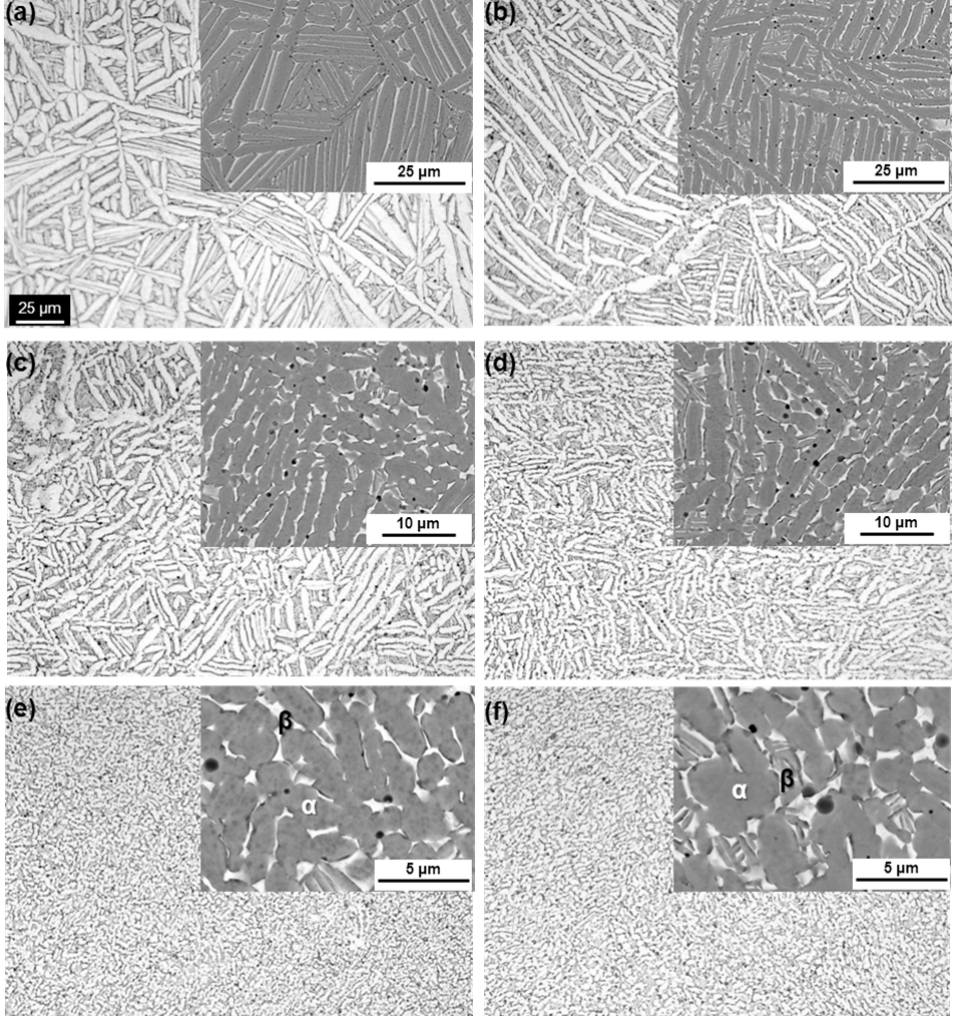
Figure 7. Comparison of optical microscopy and SEM images of Ti-15Zr-4Nb-4Ta alloy A forged at 760 °C. ( a ) β -Annealed; ( b ) forging ratio of 2; ( c ) forging ratio of 3; ( d ) forging ratio of 5; ( e ) forging ratio of 10 and ( f ) forging ratio of